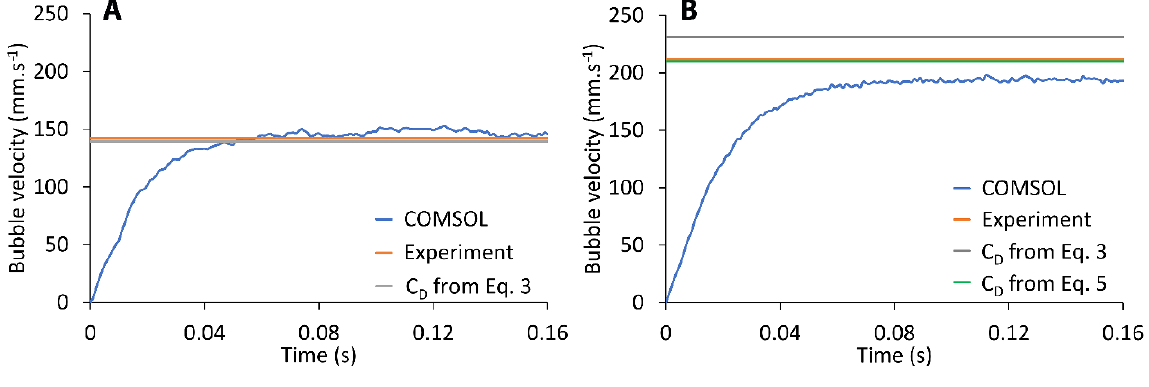
Figure 3. ( A ) Time-dependent velocity of a 0.6 mm bubble rising in pure water, compared to steady-state experimental value and theoretical computed using the Mei drag coefficient (Equation (3)) for a spherical bubble. ( B ) Time-dependent velocity of a 0.8 mm bubble rising in pure water, compared to steady-state theoretical value computed using Moore expression (Equation (5)) for a slightly deformed bubble.